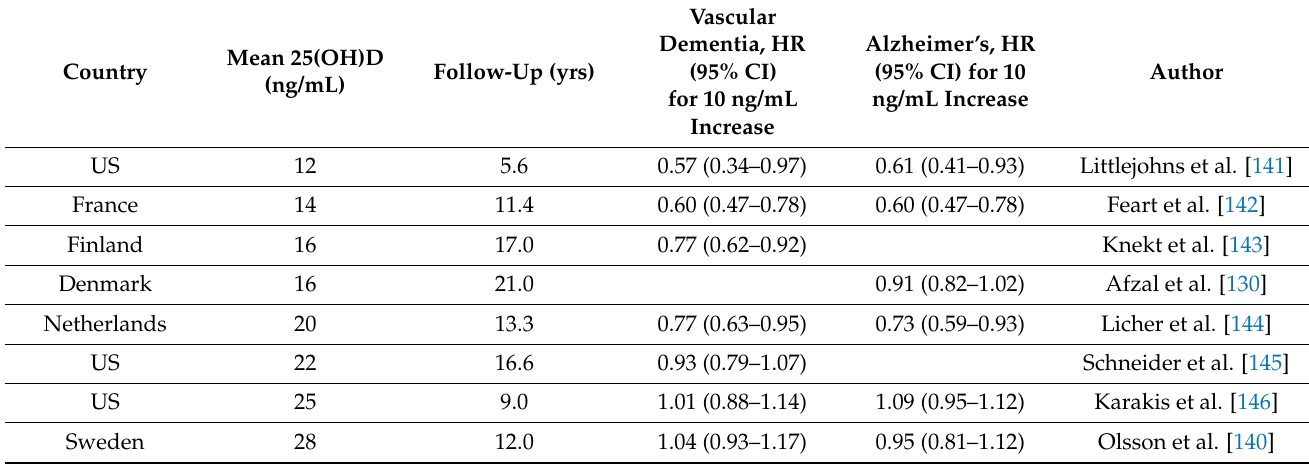
Table 3. Data associated with the observational studies in the meta-analysis by Jayedi and colleagues